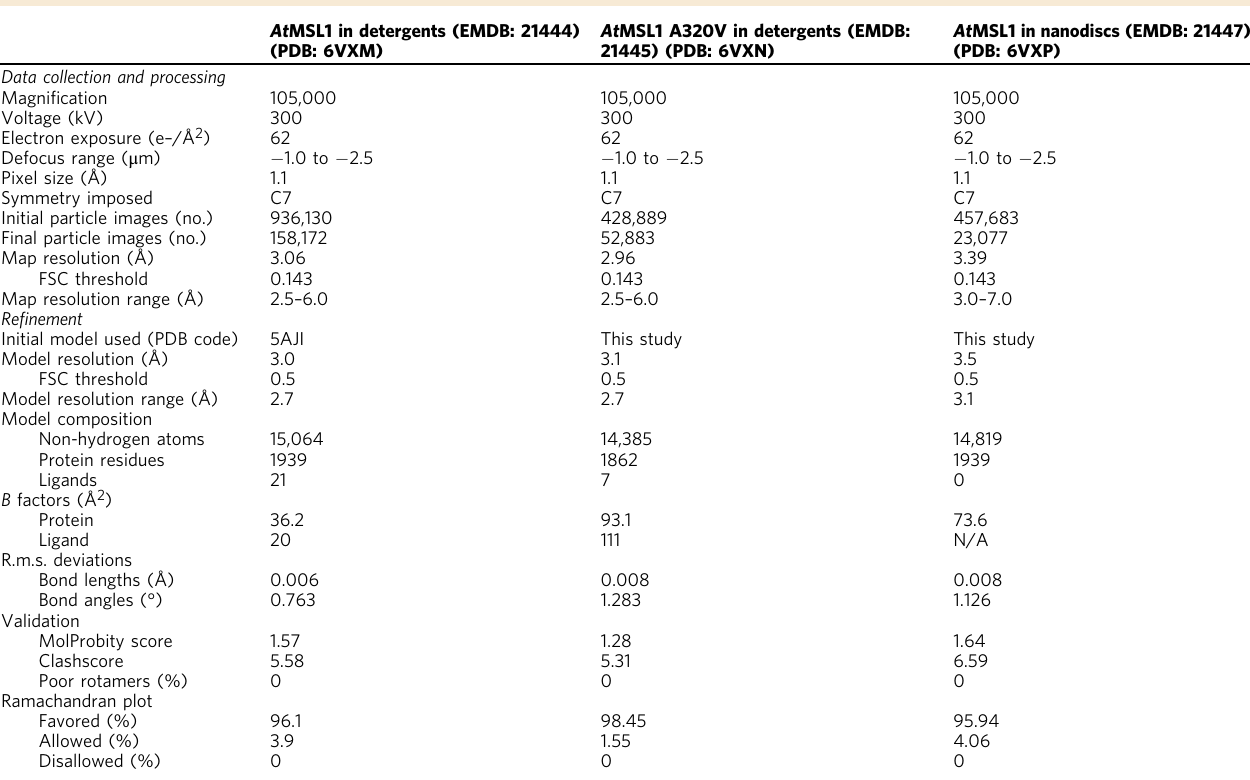
Table 1 Cryo-EM data collection, re fi nement and validation